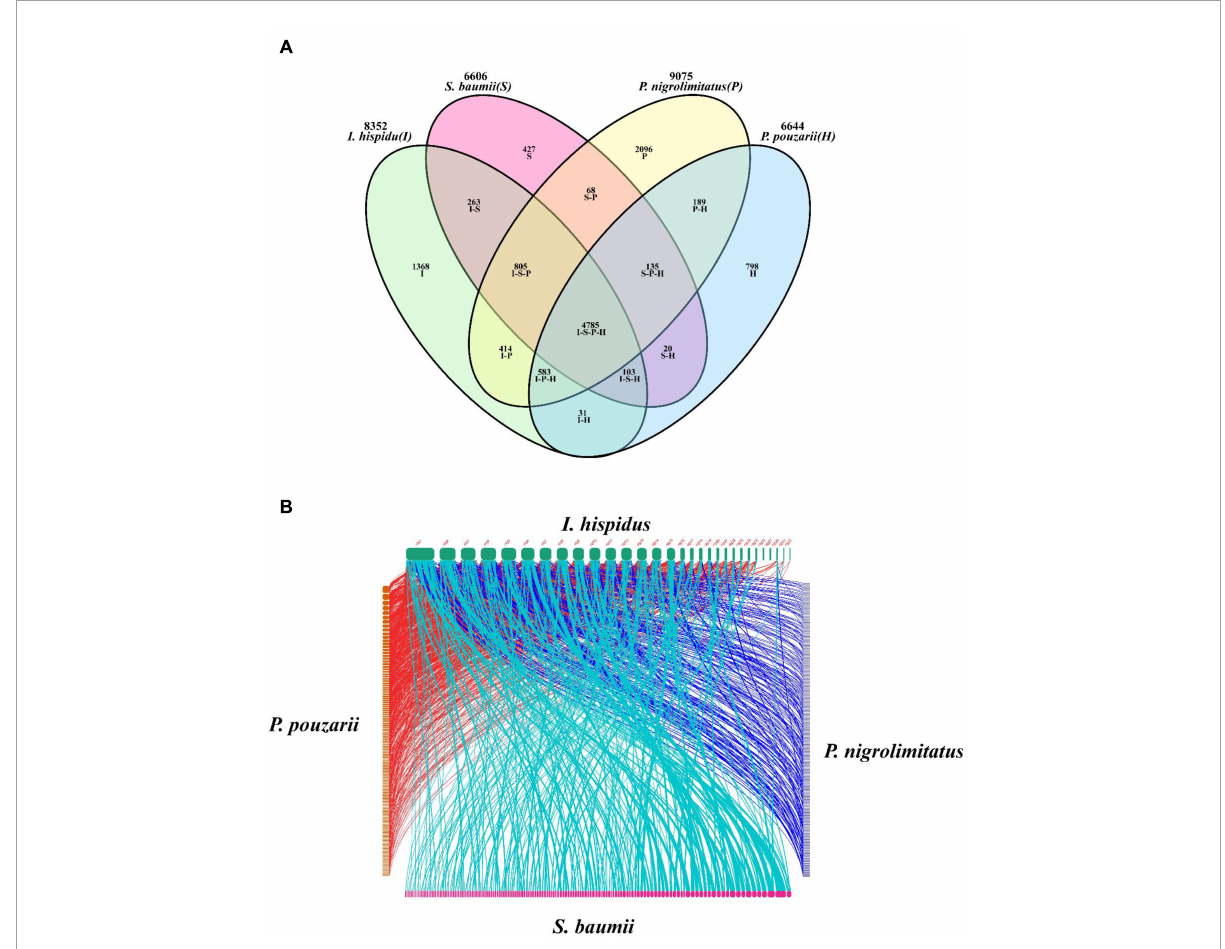
FIGURE11 Comparative genomic analysis of I. hispidus and other three fungi. (A) Venn diagram of I. hispidus , S. baumii, P. nigrolimitatus , and P. pouzarii . (B) Genome synteny of I. hispidus, S. baumii , P. nigrolimitatus , and P. pouzarii